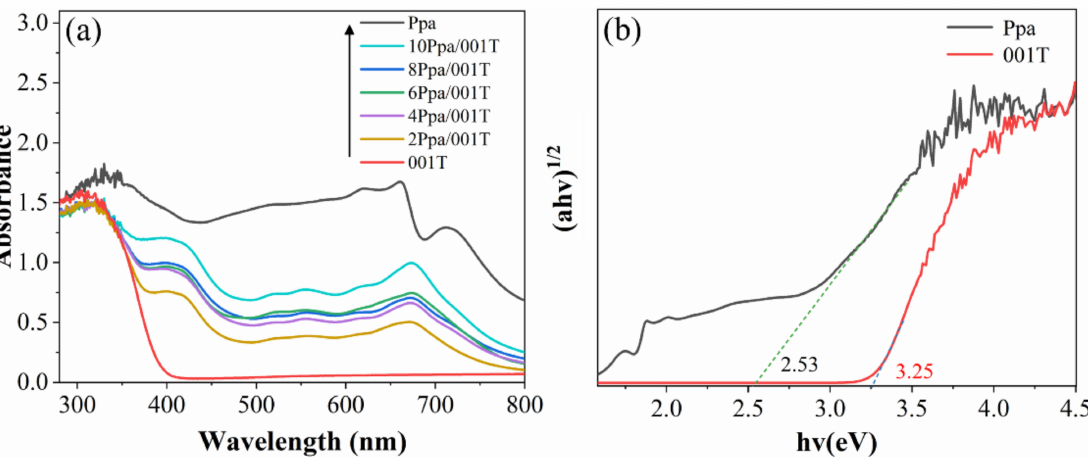
Figure 2. ( a ) DRS spectra of Ppa, 001T, xPpa/001T; ( b ) estimated band gap curves of Ppa and